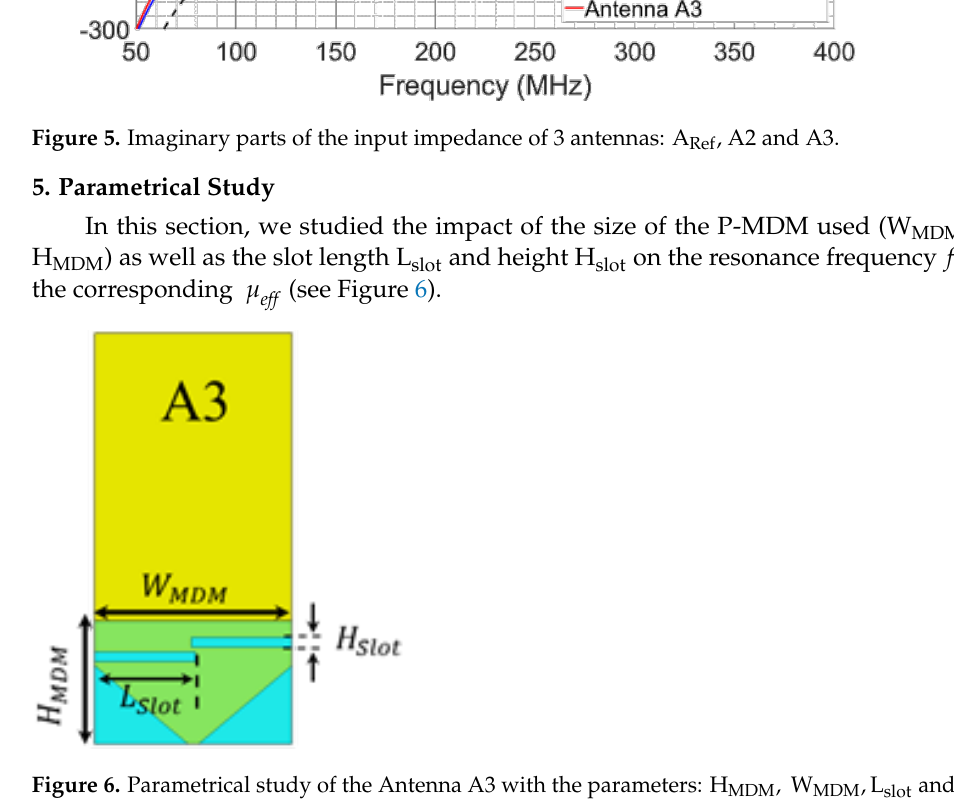
Figure 5. Imaginary parts of the input impedance of 3 antennas: A Ref , A2 and A3.